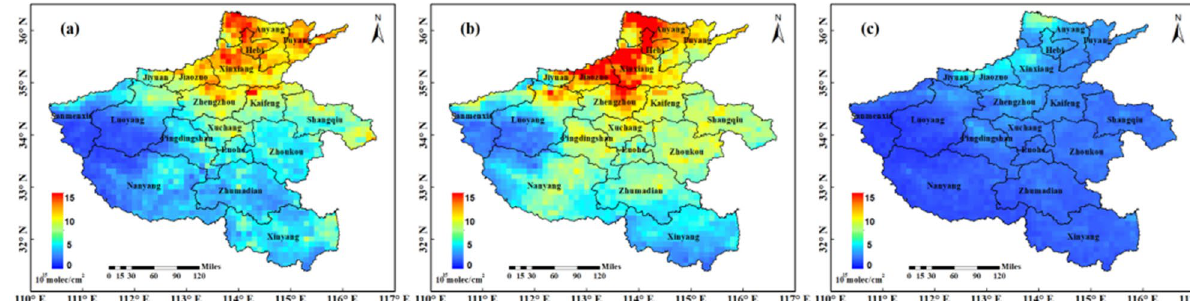
Figure 10. Spatial distribution of tropospheric NO 2 VCDs of TROPOMI (× 10 15 mol/cm 2 ) in Henan Province: ( a ) Previous year of pandemic period (from January 21, 2019 to February 20, 2019); ( b ) Previous month of pandemic period (from December 21, 2019 to January 20, 2020); ( c ) COVID-19 pandemic period (from